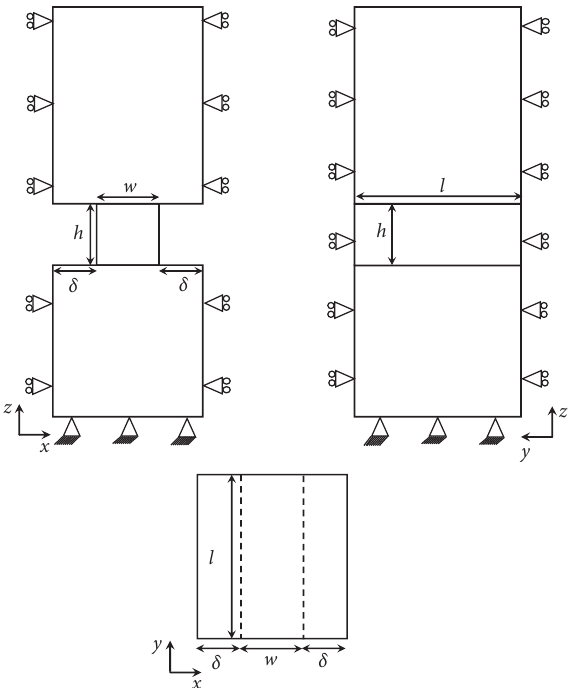
Figure 7: Schematic diagram of the local model. Note: l is the width of the local